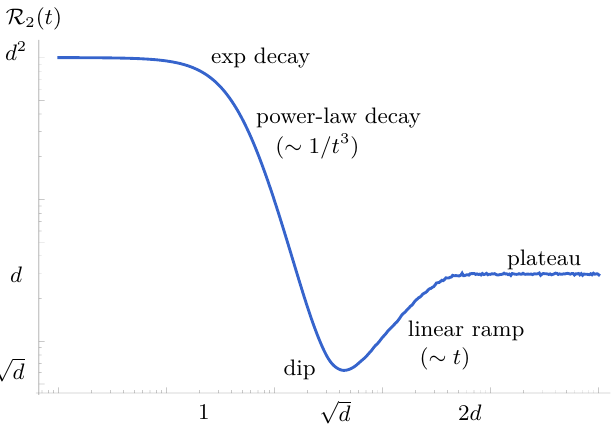
√ d followed by a linear ramp